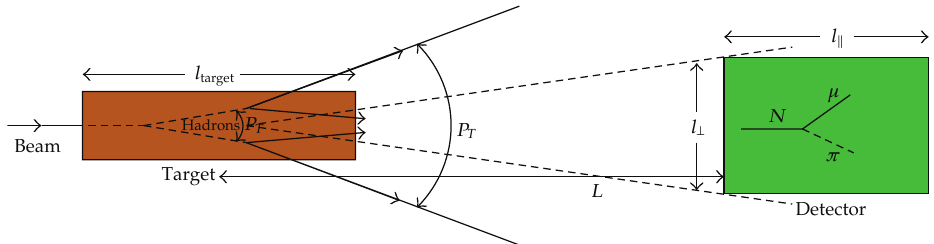
Figure 7: Sketch of typical beam-target experiment on searches for sterile neutrino